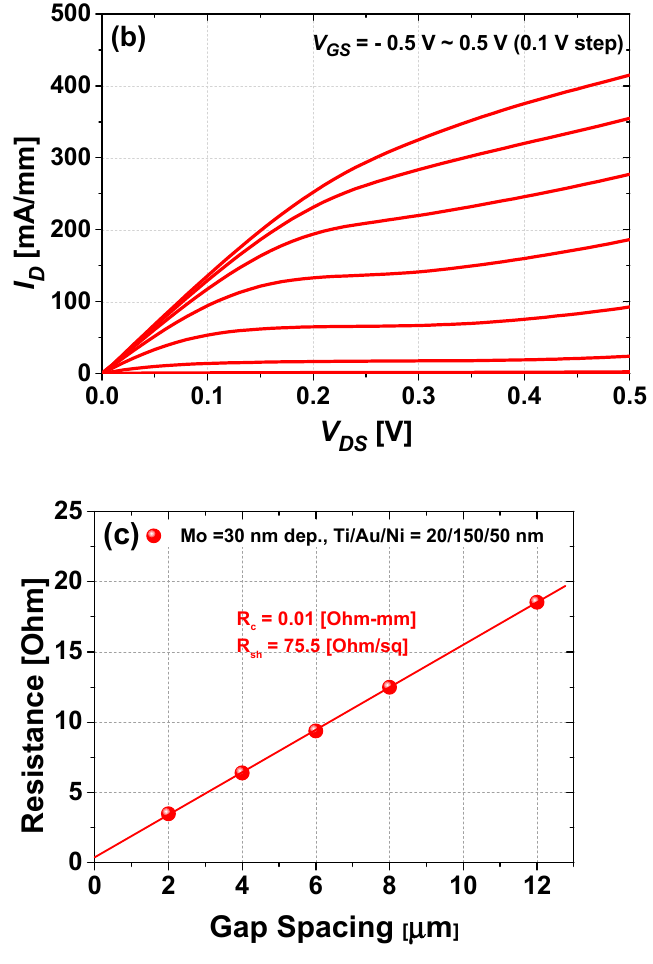
Figure 2. ( a ) Typical transfer characteristics of the mHEMTs measured at V DS = 0.5 V. ( b ) Typical output characteristics of the mHEMTs ( V GS = − 0.5 V ~ 0.5 V). ( c ) TLM result of the Mo-based Ohmic contact.